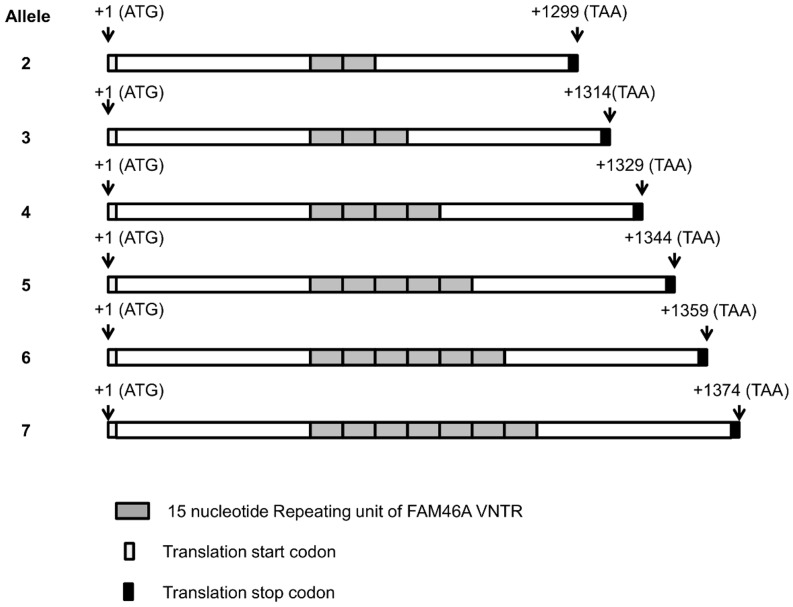
Schematic representation of FAM46A mRNA alleles in CCDS.Cloning and sequencing of FAM46A mRNA from our studied population generated six variants of the FAM46A gene that were different at the VNTR site. FAM46A alleles 3, 4, 5, and 6 (UniProt identifiers: >sp|Q96IP4|29-33), (>sp|Q96IP4|24-28), (>sp|Q96IP4|34-38) and (>sp|Q96IP4|39-43, respectively) were previously reported. Our submission of the sequences for FAM46A allele 2 and 7 to the GenBank has recently (06.02.2014) been accepted for publication with accession numbers KF878392 and KF878393, respectively.